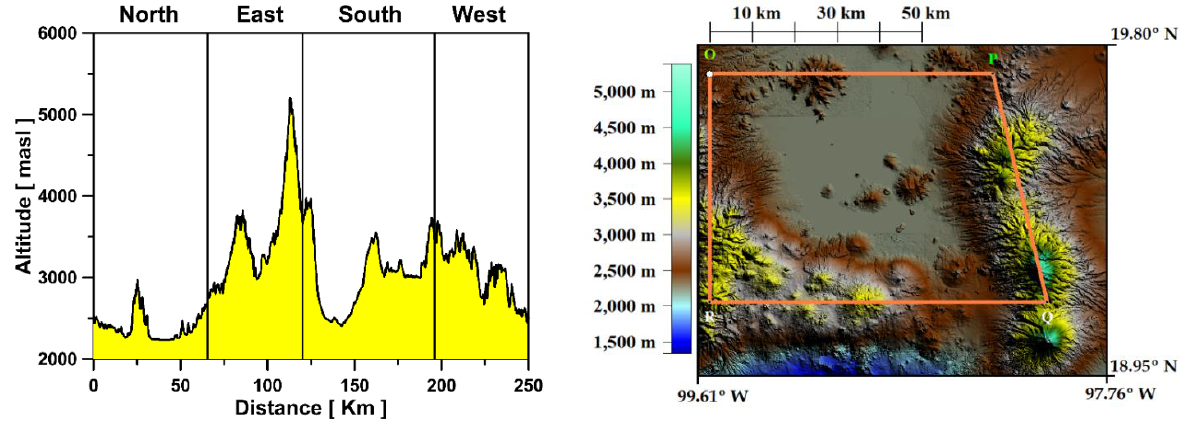
Figure 1. Altitude profile (left) of the mountains that surround the Mexico City basin